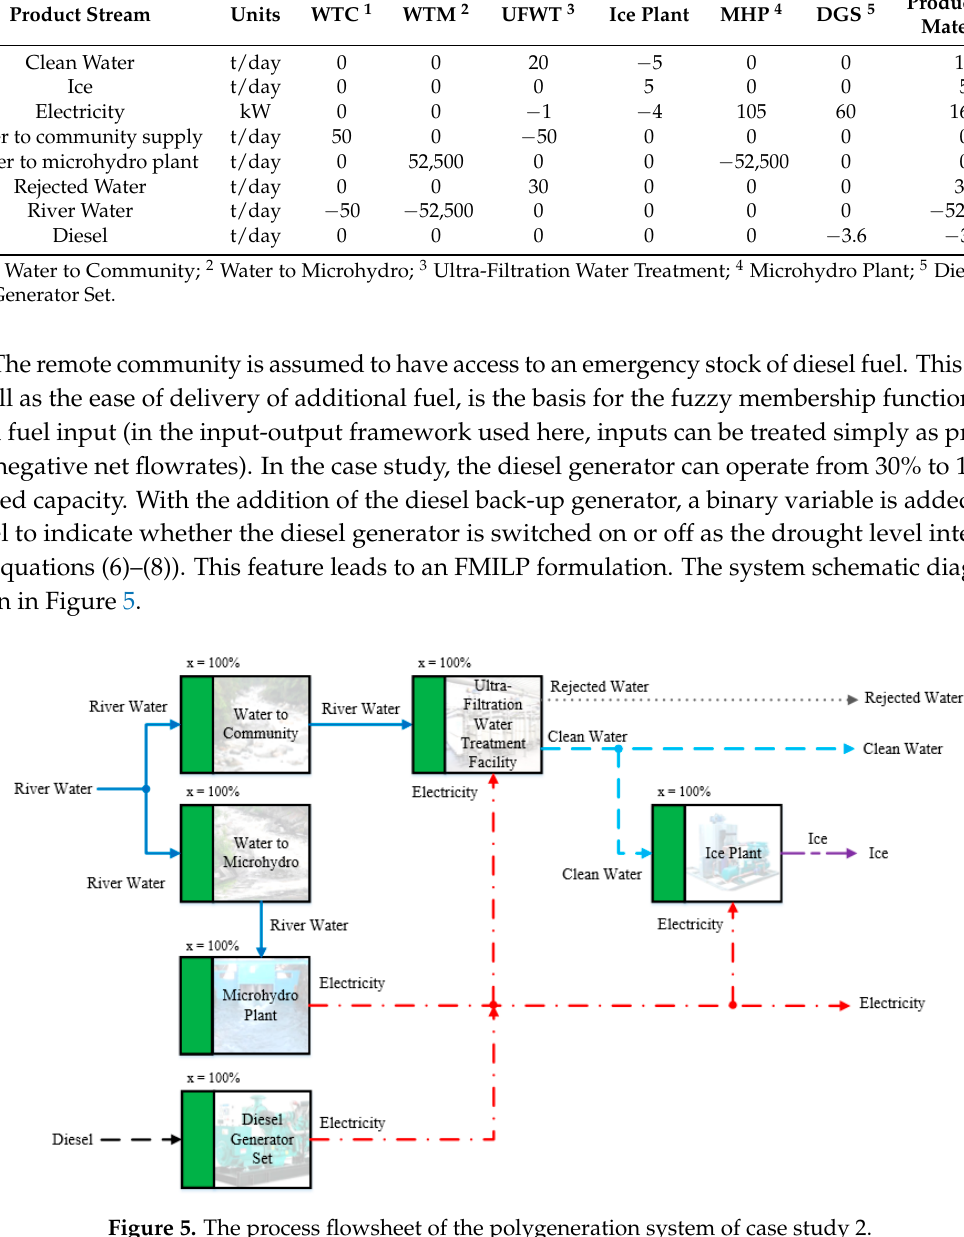
Table 4. The balanced process matrix of case study 2.